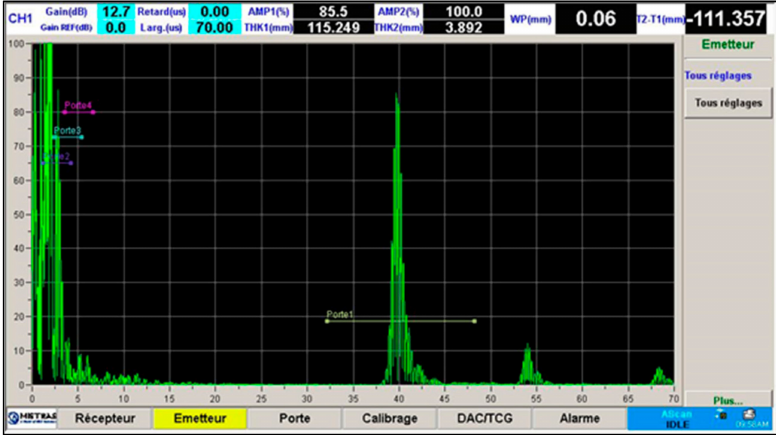
Figure 9. A-scan at incidence = 0 ◦ , scanning position = 30 mm, sodium temperature = 200 ◦